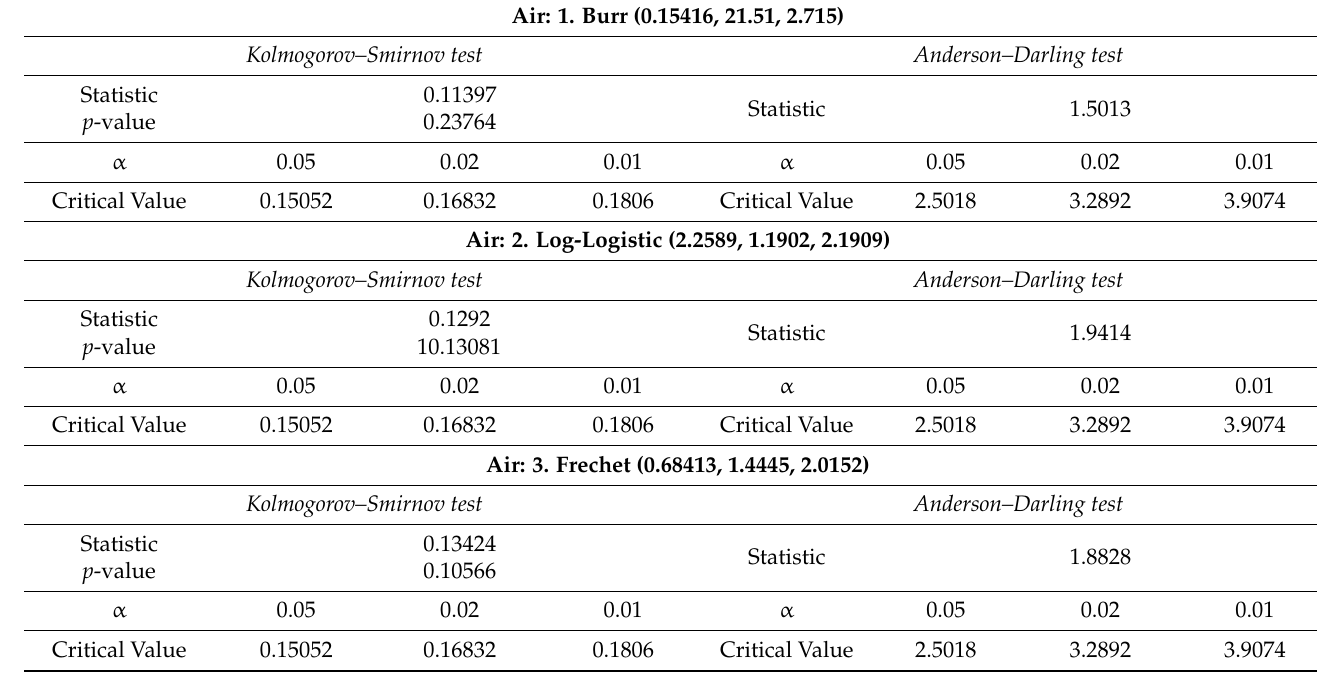
Table 12. Details of the goodness-of-fit tests for the alloy